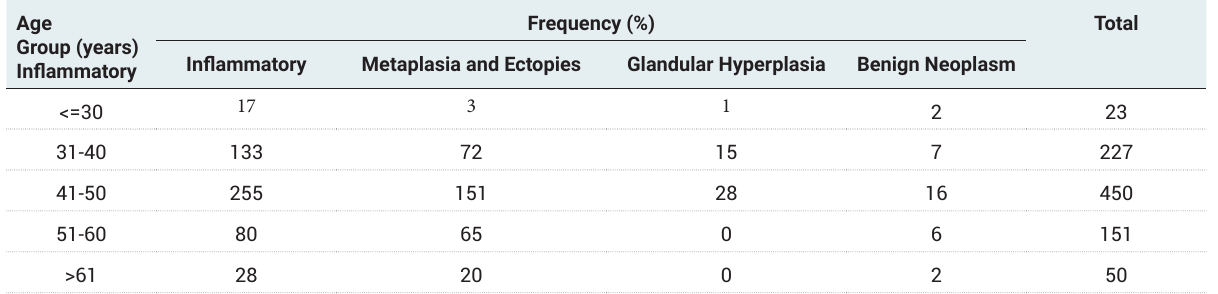
Table 3: Age wise distribution of various cervical lesions